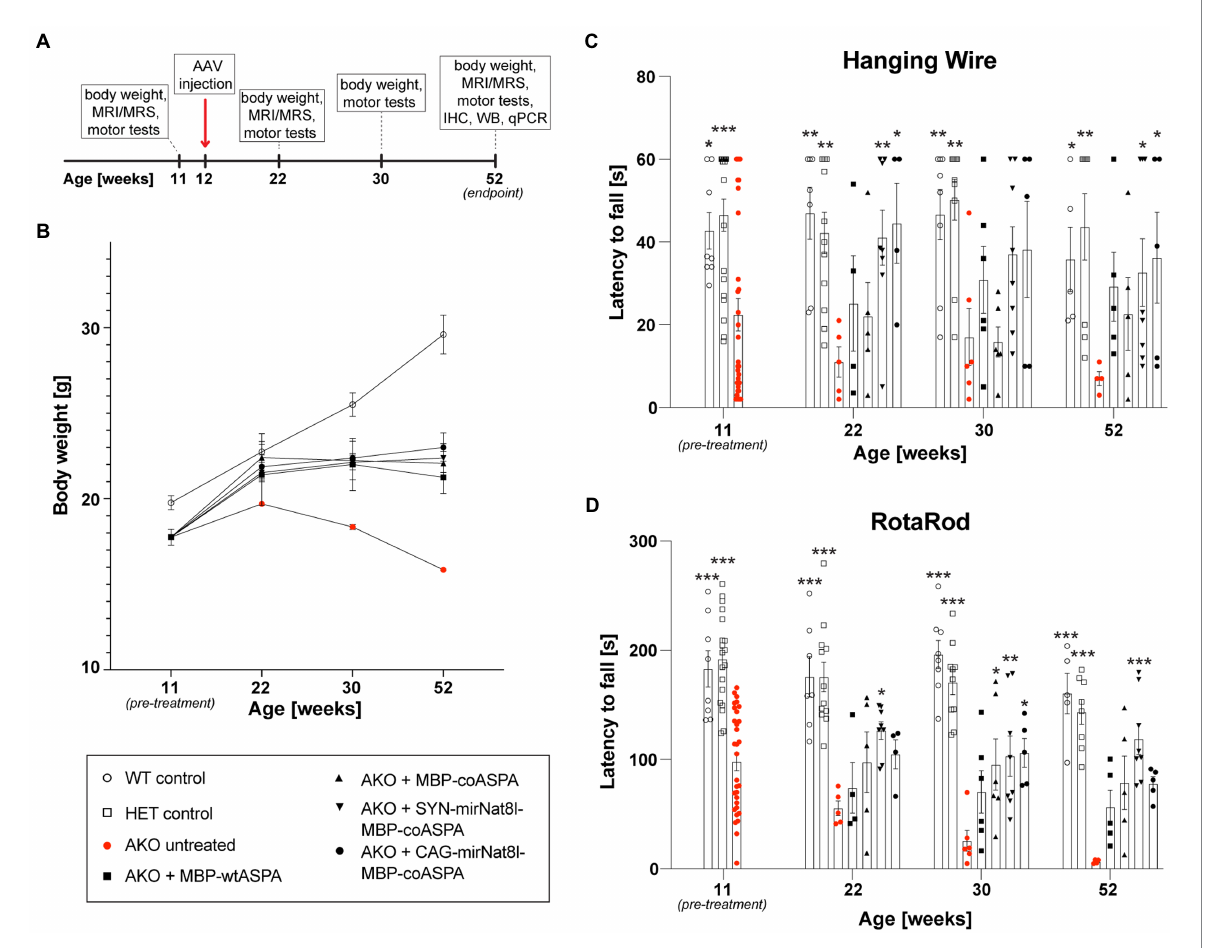
FIGURE 5 Dual-function AAV vectors improve motor function and stop age related weight loss in post-symptomatic (12-week-old) AKO mice. (A) Schematic depicting the study design for the treatment of AKO mice with advanced-stage Canavan pathology (IHC = immunohistochemistry, WB = western blotting, qPCR = quantitative real-time PCR). (B-D) AAV vectors were injected bilaterally into striatum, thalamus, and cerebellum (3 × 10 9 vg per site) of 12-week-old AKO mice. Body weight (B) and motor behavior (C,D) were assessed before the treatment as well as 10-, 18-, and 40-weeks post- treatment using the Hanging Wire (C) and Rota Rod (D) tests ( n = 4–8). Data represent mean ± SEM. * p < 0.05, ** p < 0.01 *** p < 0.001; Two-way ANOVA with Bonferroni post-hoc test. Significance is displayed in comparison to AKO